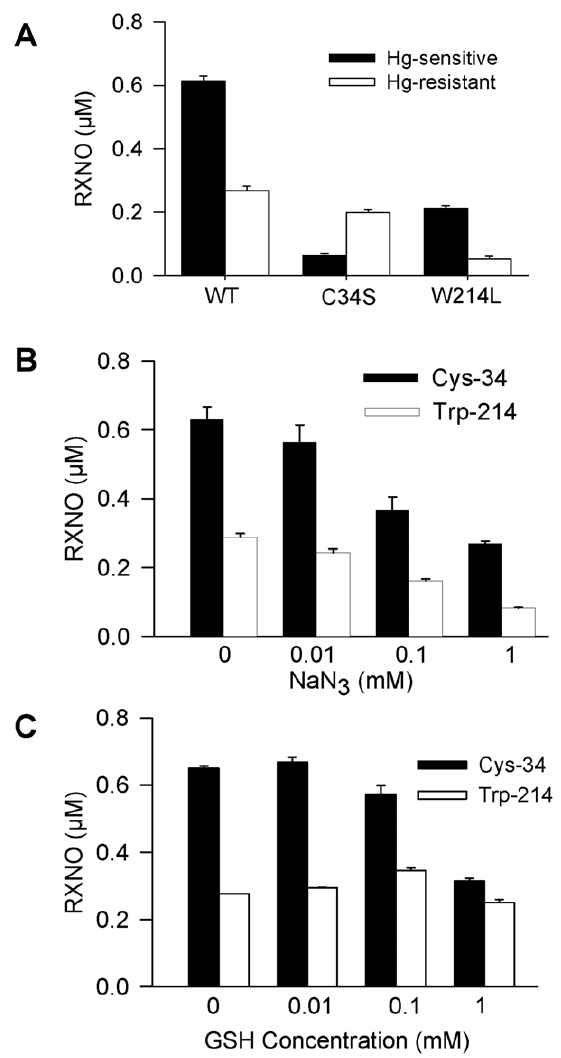
Figure 7. Site-directed nitrosation of human albumin. ( A ), The presence of mercury-sensitive and -resistant species in wild-type (WT), C34S and W214L recombinant HSA (3 mg/ml) treated with 20 m M DEA/ NO for 30 min at 37 u C was determined by reductive chemilumines- cence. The effect of sodium azide ( B ) and GSH ( C ) on the amount of nitrosated Cys-34 and Trp-214 was determined after desalting of the samples. The values represent the mean 6 SEM (n=3).